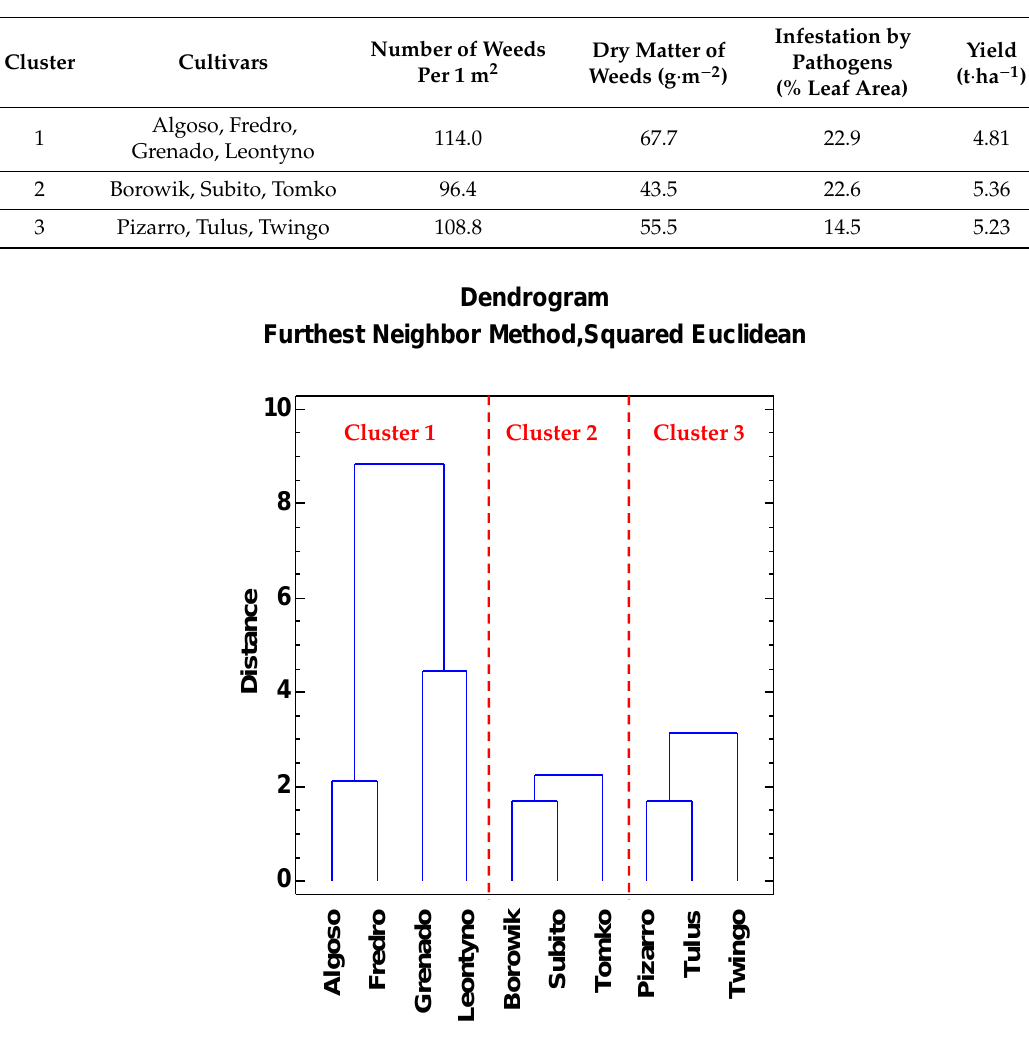
Figure 1. Dendrogram for cluster analysis of winter triticale cultivars grown in the organic system.